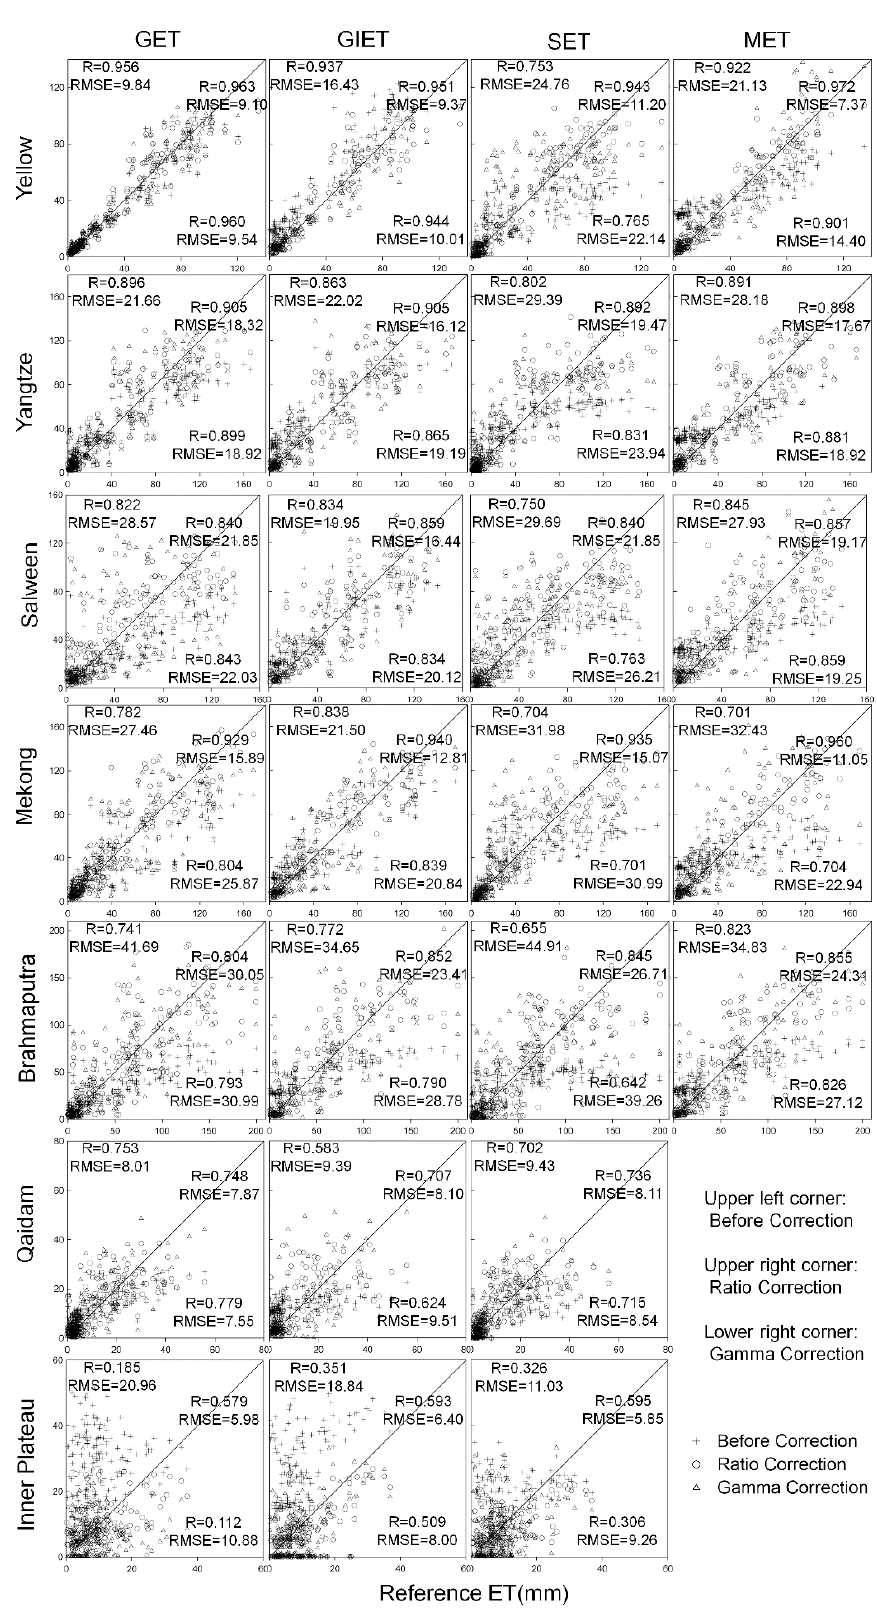
Figure 8. Comparison of the monthly ET p with the ET ref before and after correction for the seven sub-basins on the Tibetan Plateau The vertical axis represents ET p before correction, after ration correction, and after gamma correction, respectively.